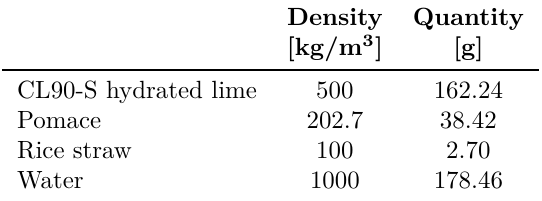
Figure 3. Prototype 1.